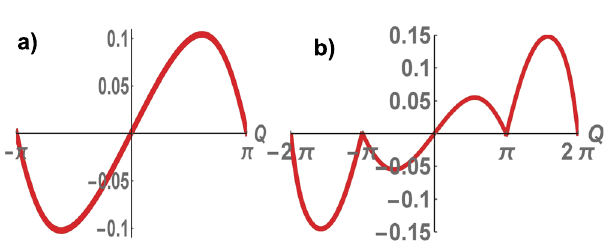
Figure 6. Persistent currents as function of the flux Q at µ = 1 regime of strong tunneling τ τ = > = . 0 57 tunneling